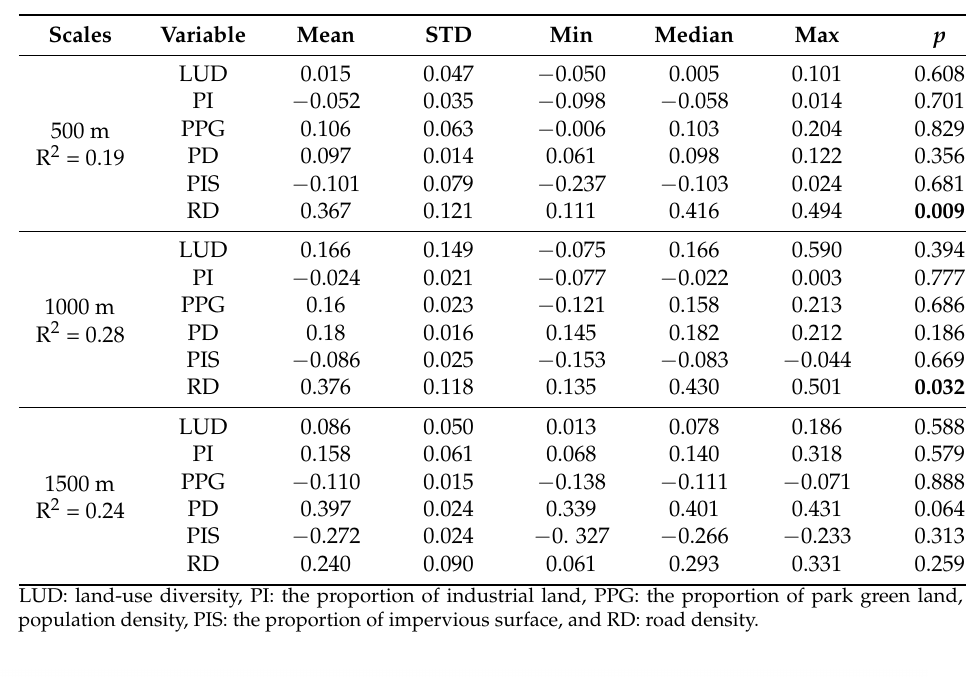
Table 2. The statistical description of multi-scale geographically weighted regression (MGWR) coefficient. Bold numbers represent significant differences.